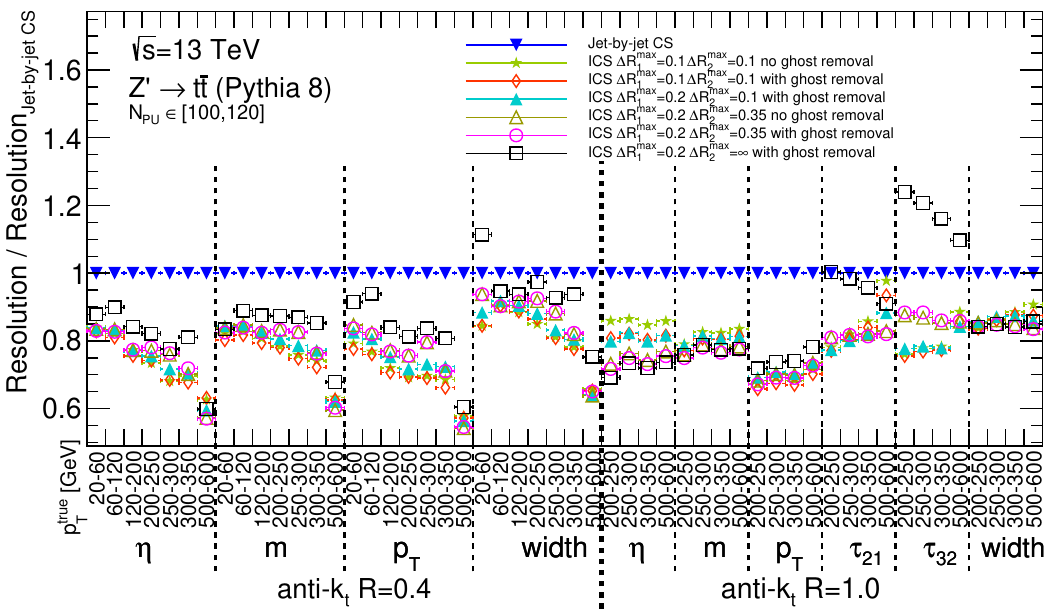
Figure 17. Resolution for a representative set of con(cid:12)gurations for the ICS method with two iterations. The (cid:1) R max parameter for the individual iterations is varied and the ghost removal option is used or not. The other CS parameters are set to (cid:11) = 1 and A g = 0 : 0025 for each